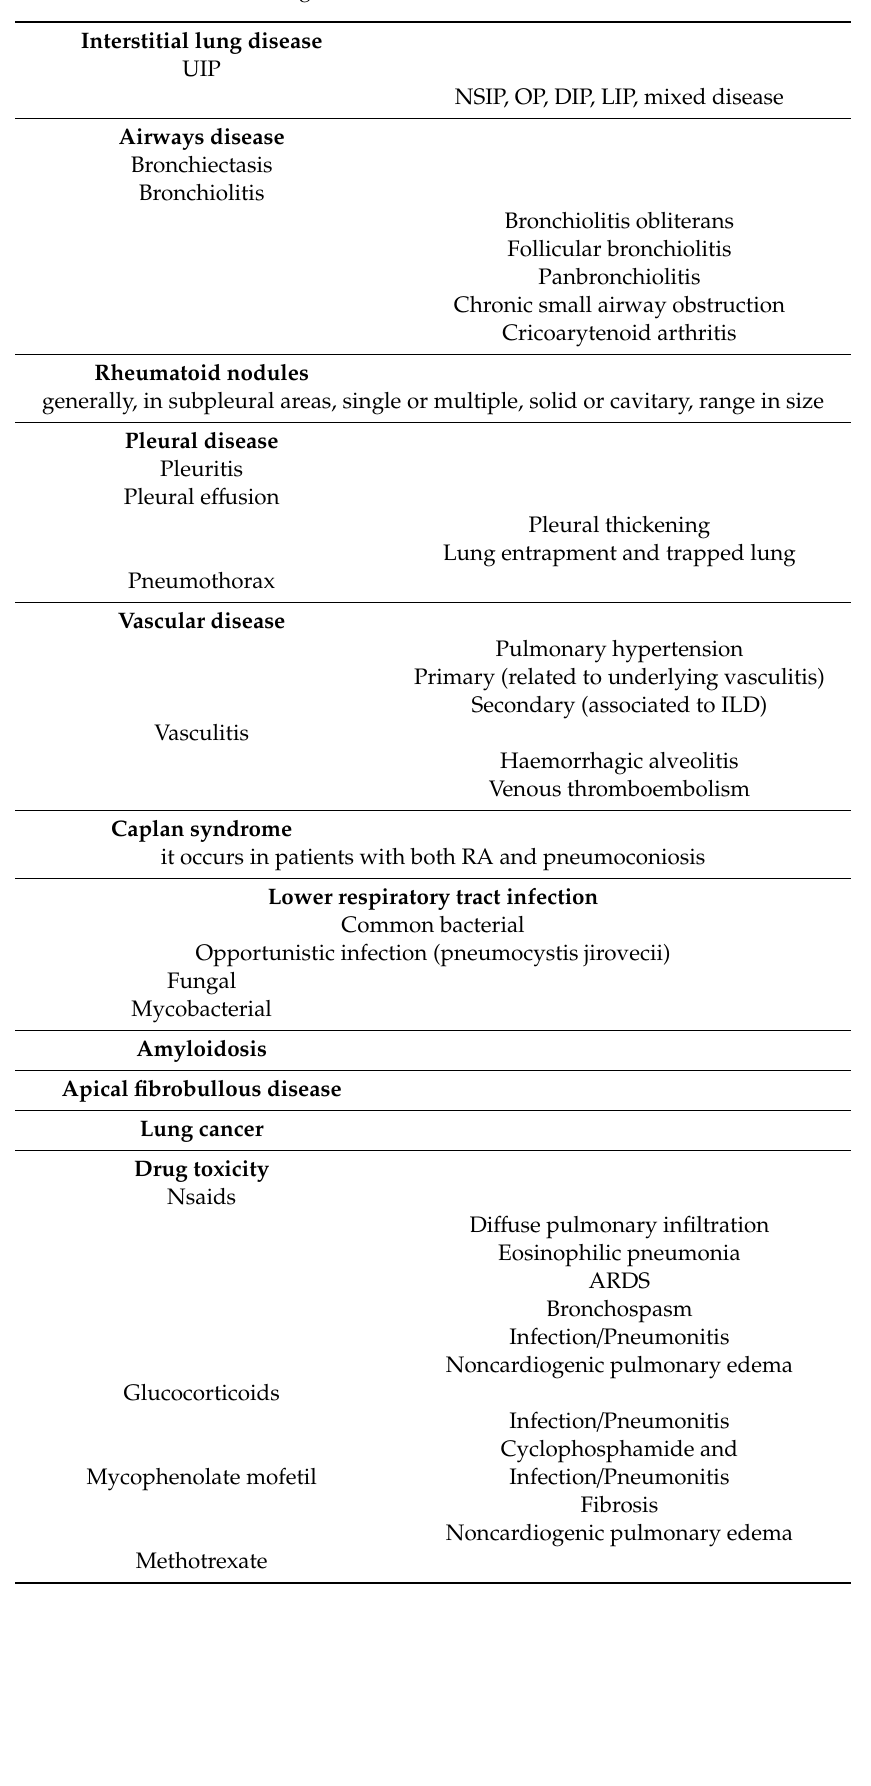
Table 1. Lung involvement in Rheumatoid